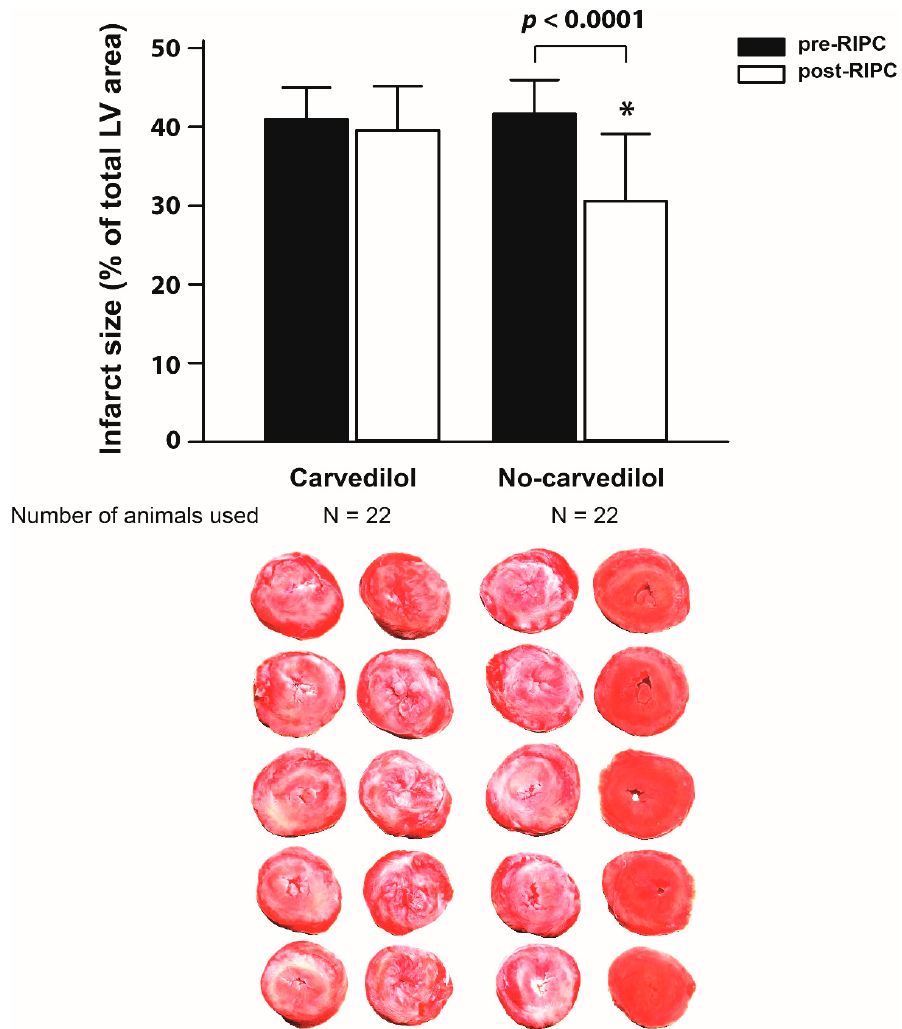
Figure 4. Comparison of pre- and post-RIPC infarct size of the Langendorff isolated rat heart model using dialysate from healthy volunteers with or without taking beta-blocker. Data are presented as mean ± SD. * p < 0.05 compared to the pre-RIPC infarct size within a group. LV, left ventricle; RIPC, remote ischemic preconditioning.